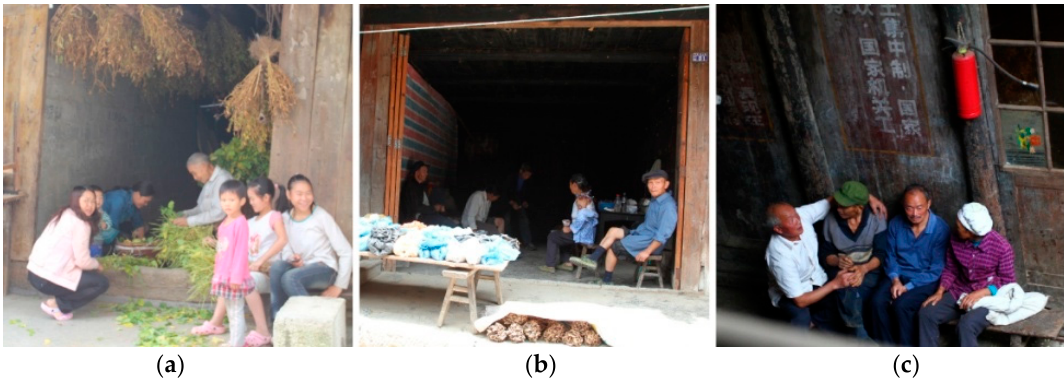
Figure 12. Daily activities taking place in the semi-open spaces of a courtyard house: ( a ) farm work, ( b )